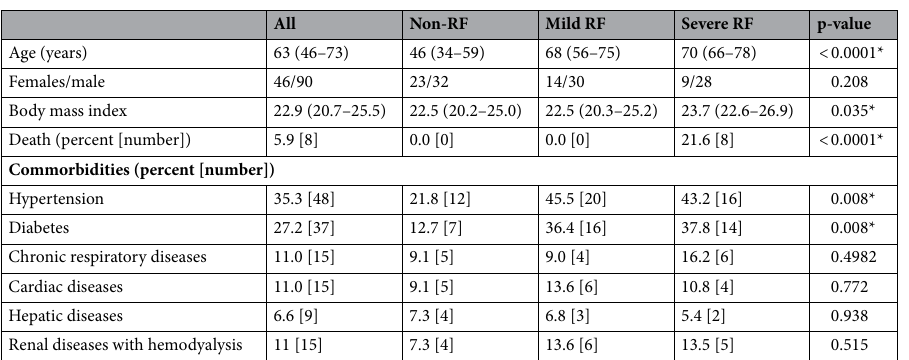
Table 1. Baseline patient characteristics and commorbidities. *p <